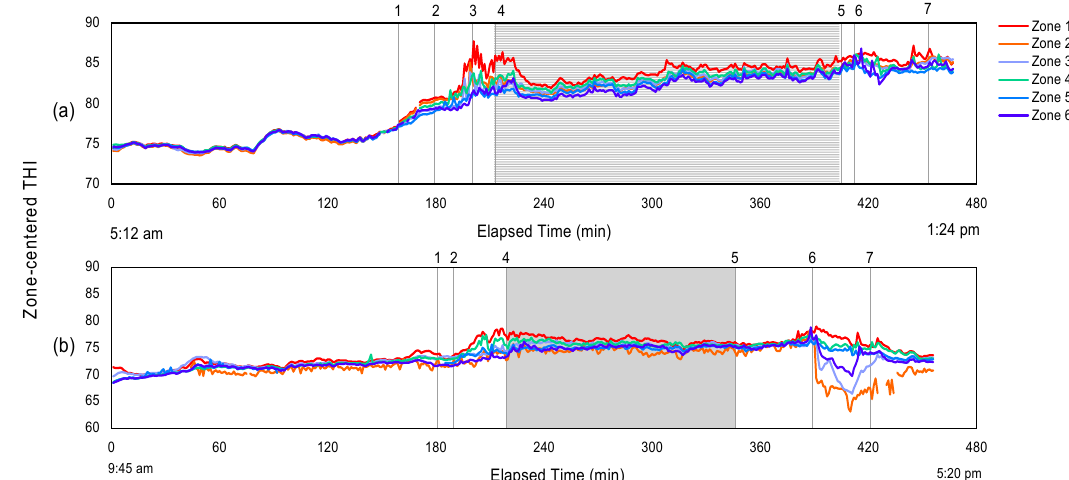
Figure 3. Ceiling-centered THI profile representing 6 zones inside a pig trailer during: ( a ) a Very Hot morning trip; and ( b ) a Warm afternoon trip. Zones 1 to 3 represent trailer top deck, and Zones 4 to 6 represent bottom deck. Events occurred during the trip are numbered on the figure as follows (if present): 1. Arrival at a commercial pig barn; 2. Loading; 3. Misting applied inside trailer; 4. En route; 5. Arrival at abattoir; 6. Access to fans and misting during waiting; 7. Unloading.